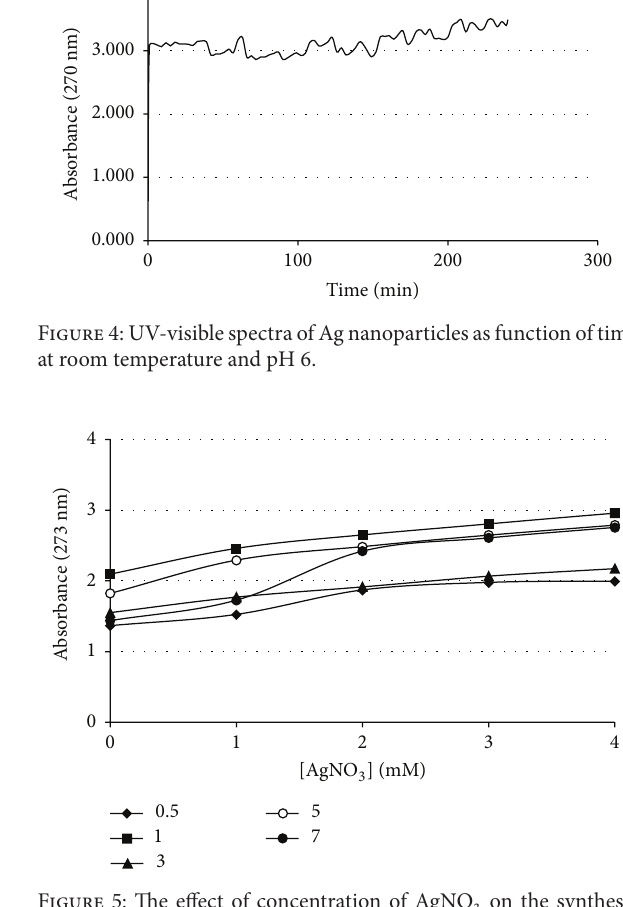
Figure 5: The effect of concentration of AgNO 3 on the synthesis of silver nanoparticles using peroxidase enzyme from Euphorbia ( Euphorbia amygdaloides